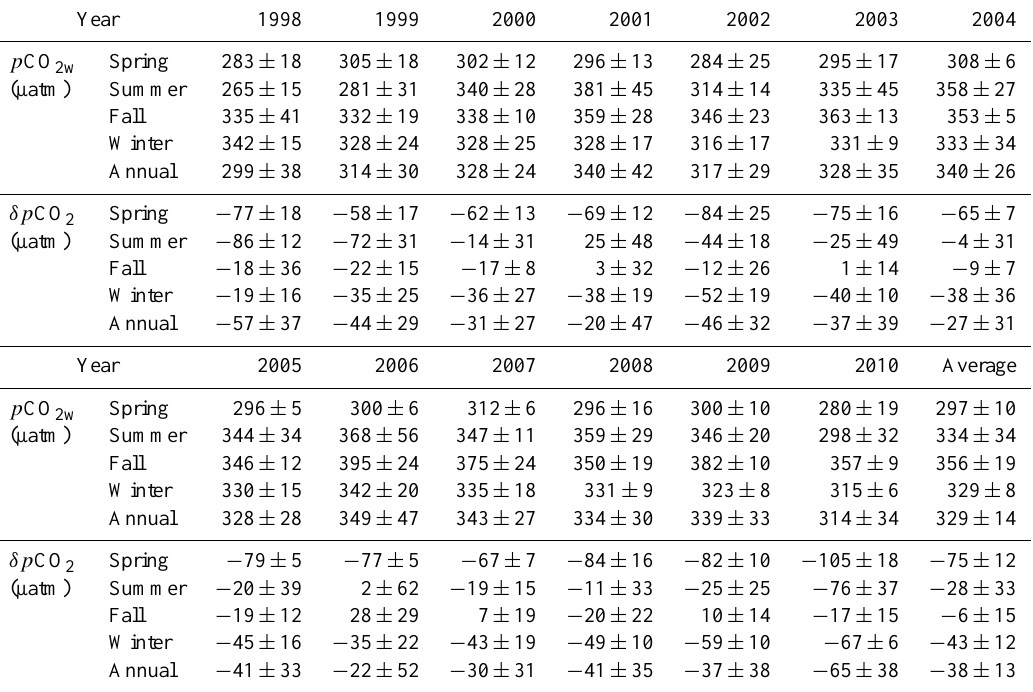
Table 2. The seasonal and annual average CO 2 results between 1998 and 2010 in the ECS shelf.